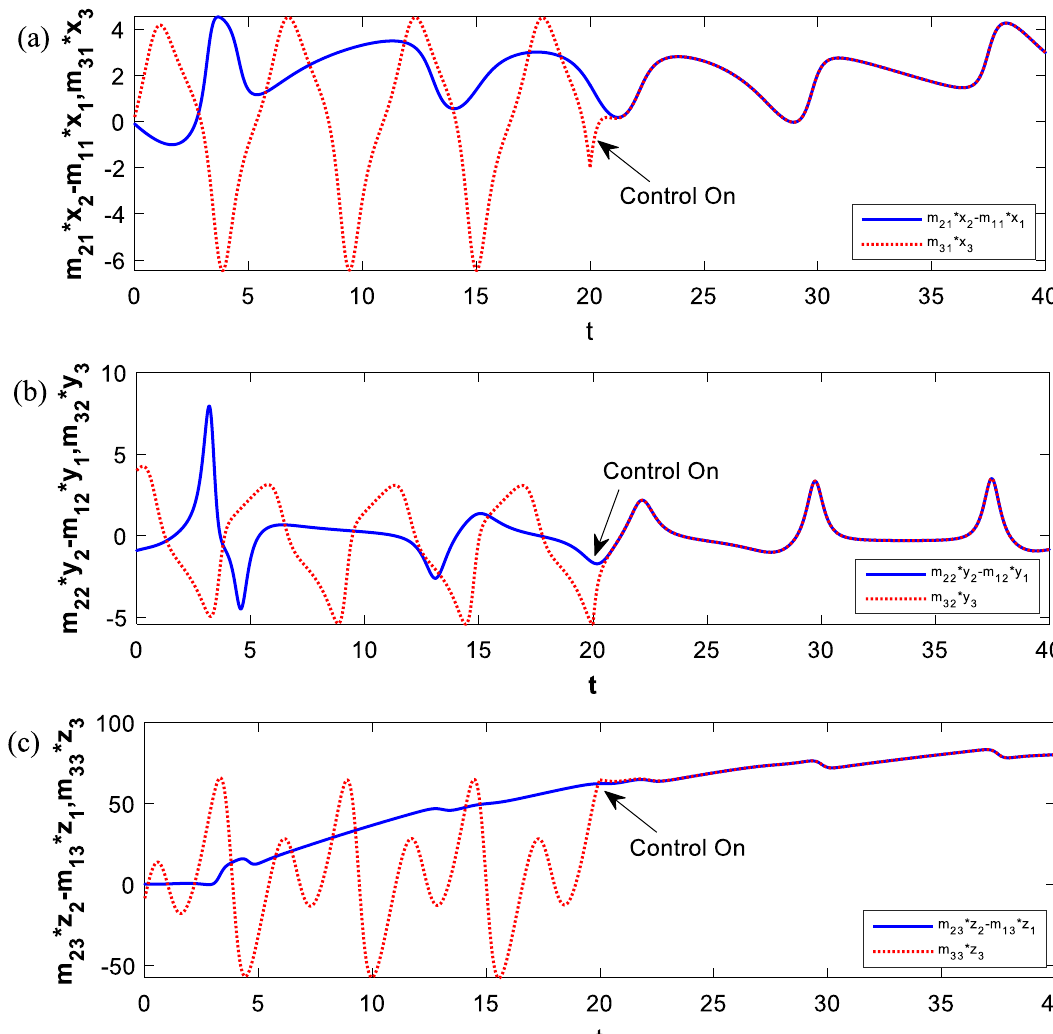
m 11 x 1 and m 31 x 3 , ( b ) −